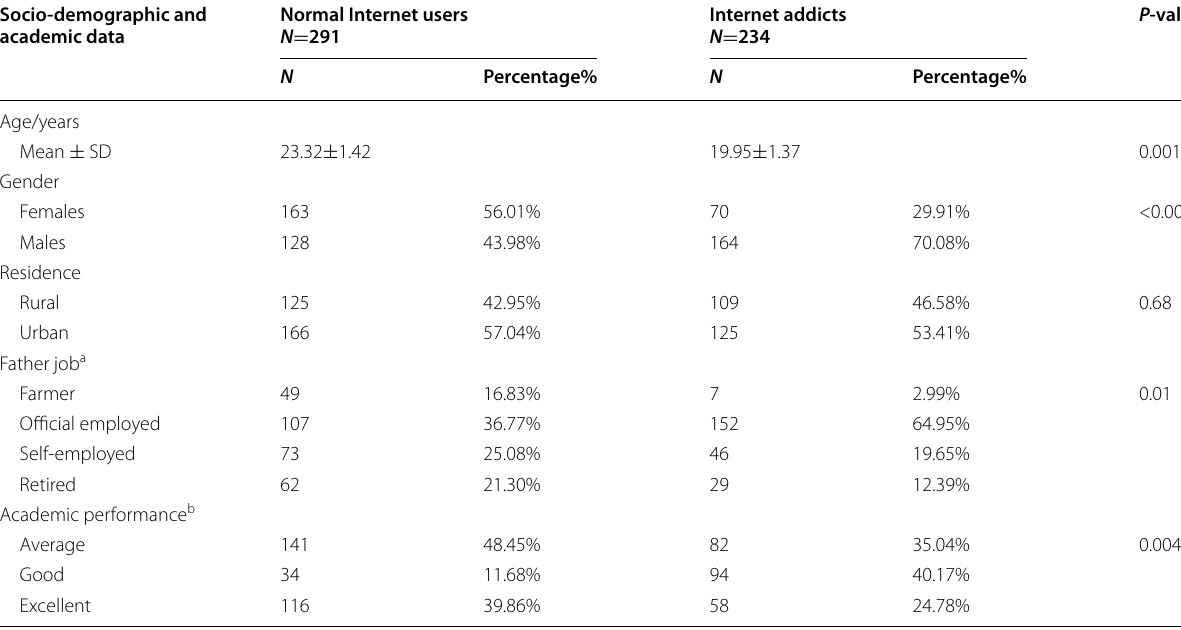
Table 1 Association between IA and socio-demographic and academic